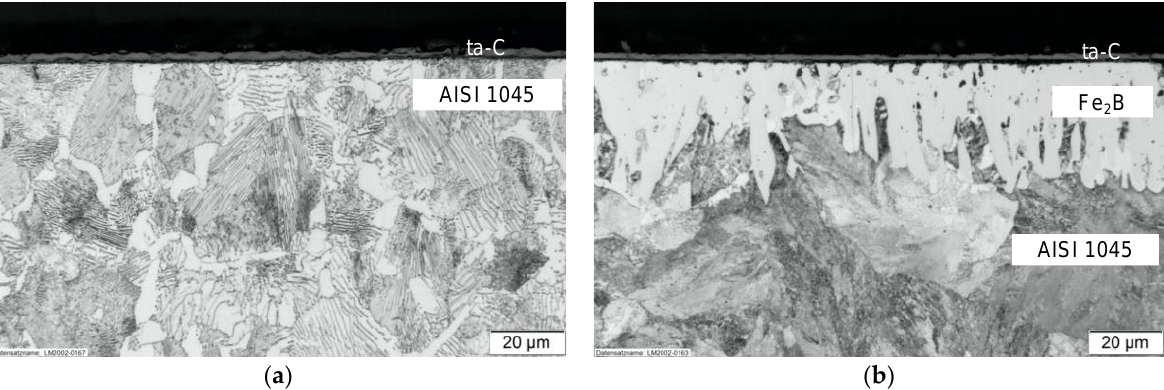
Figure 2. Five percent Nital-etched cross sections of ( a ) ta-C-coated (St-C) and ( b ) electrochemically borided and ta-C-coated (St-B-C) AISI 1045 steel.